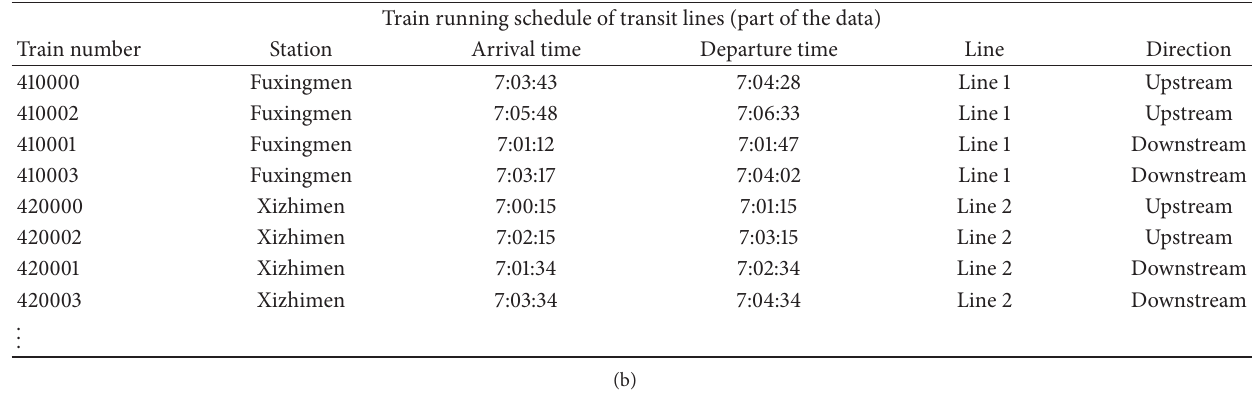
Table 2: Parts of the input data. (a)